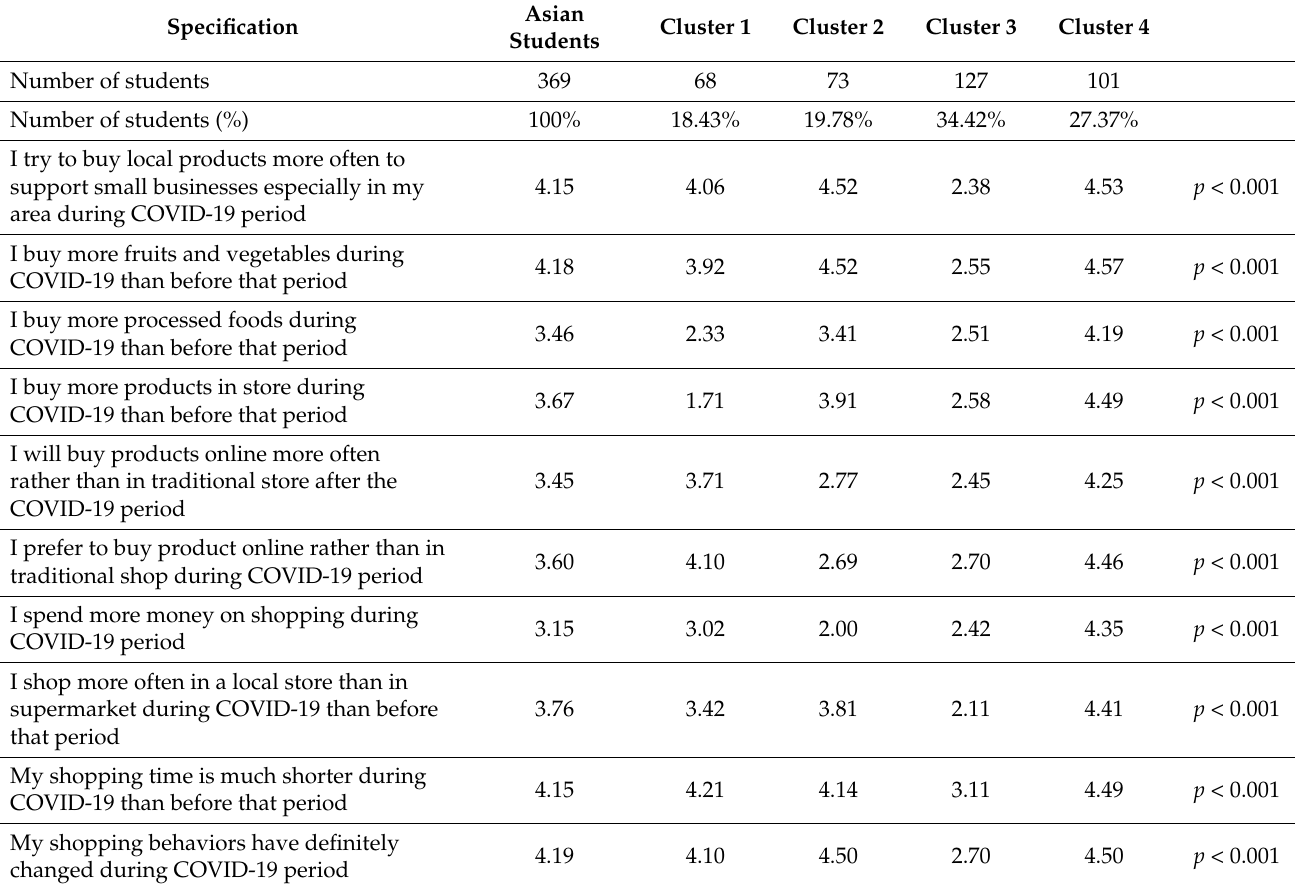
Table 8. Cluster analysis: Asian